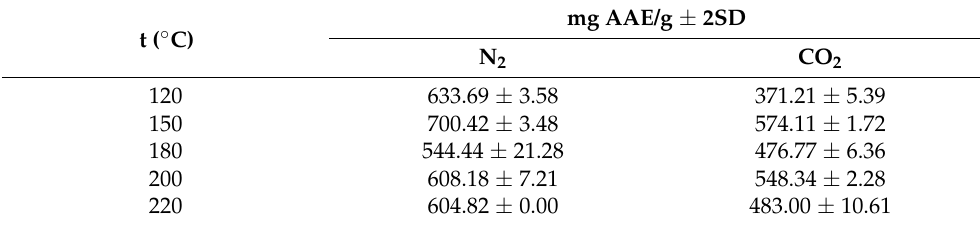
Table 4. Total antioxidant activity of lignin